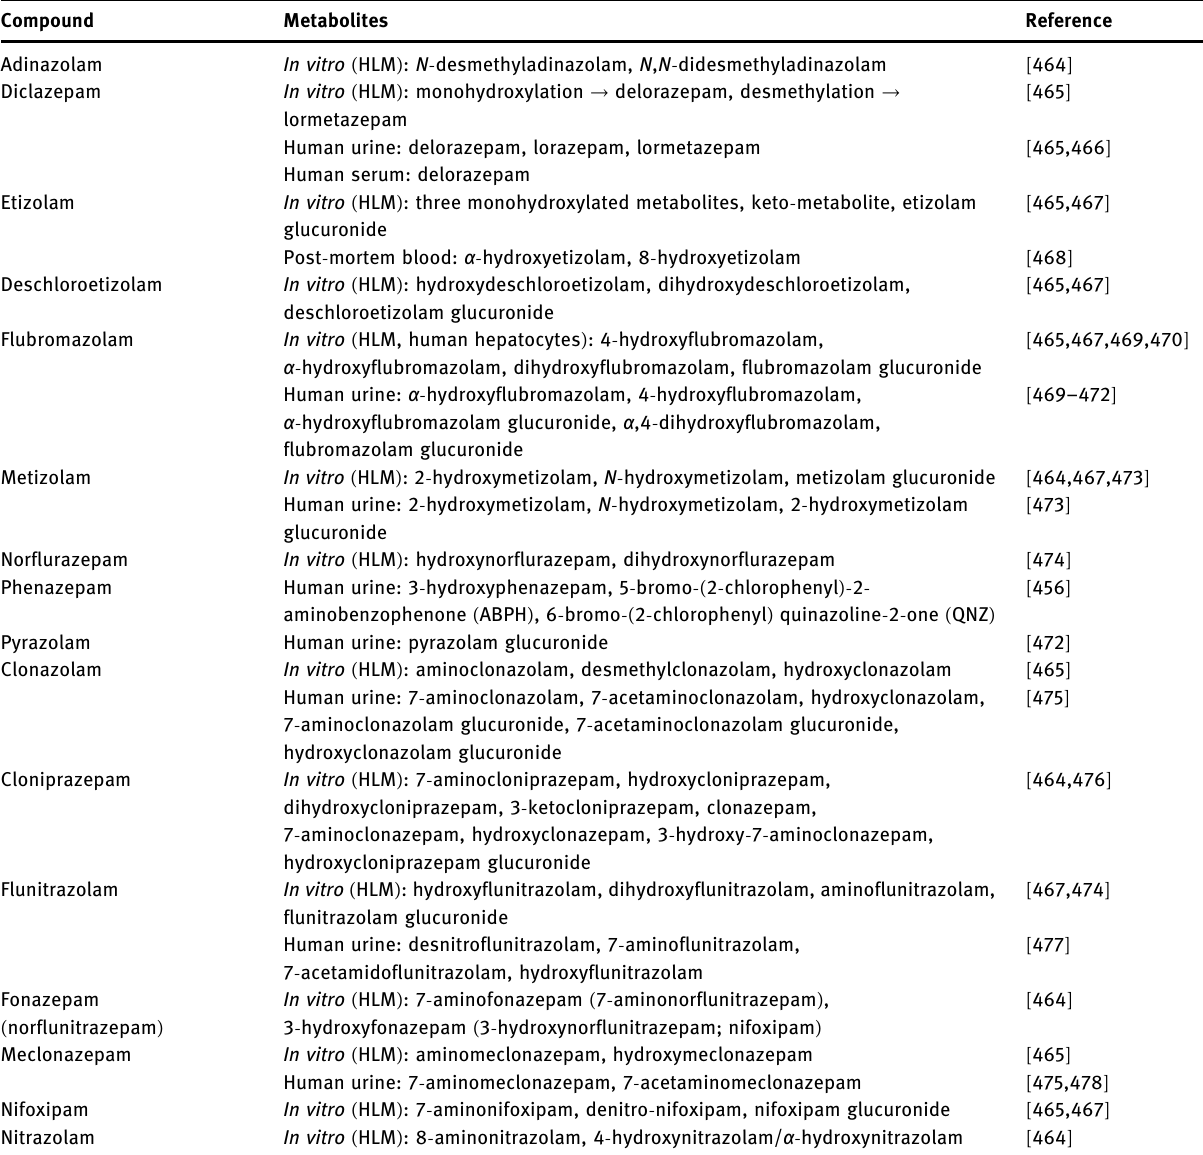
Compound Metabolites